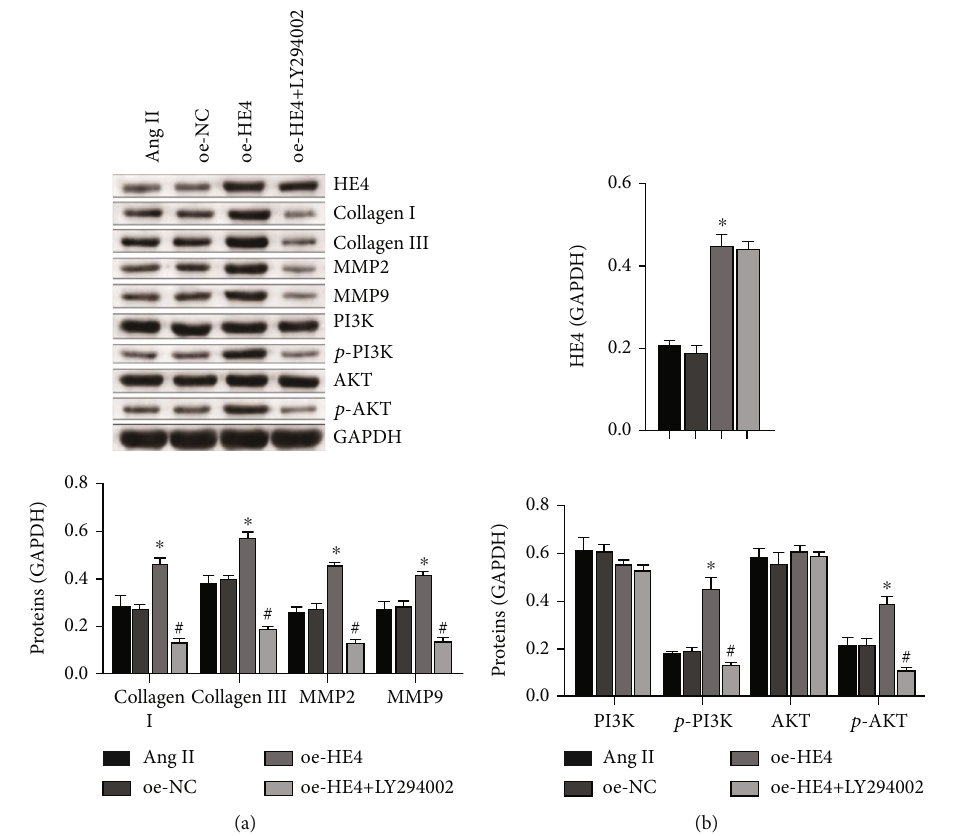
Figure 7: HE4 a ff ected myocardial fi broblast fi brosis through the PI3K/AKT pathway. (a) The expressions of HE4, collagen I, collagen III, MMP2, MMP9, PI3K, p-PI3K, AKT, and p-AKT were detected by Western blot. (b) Quantitative statistics of (a) proteins. ∗ P < 0 : 05 vs. oe-NC; # P < 0 : 05 vs.